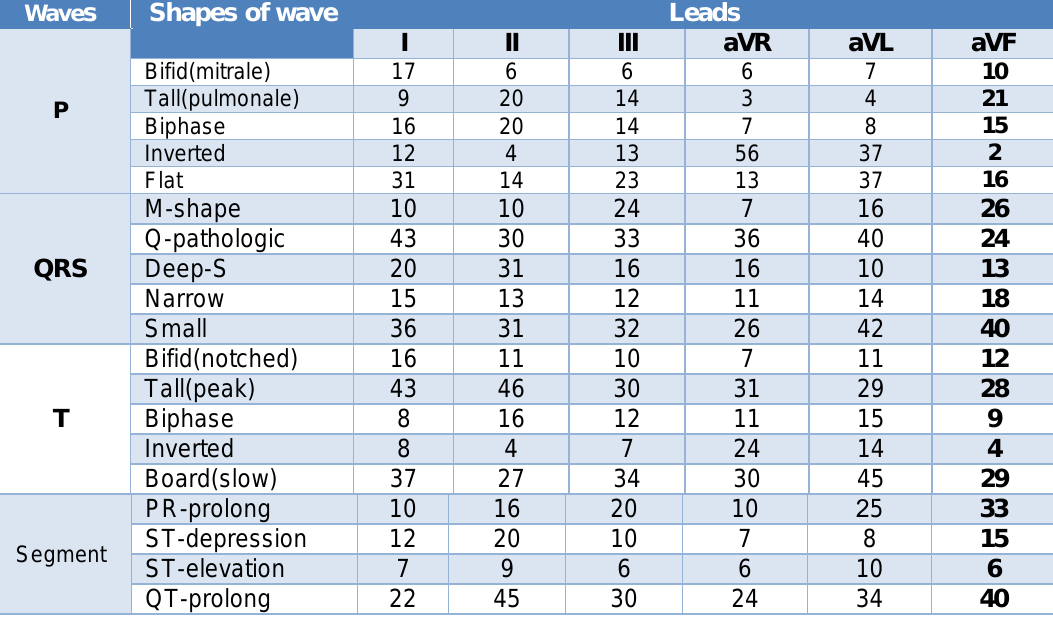
Leads Shapes of wave Wave